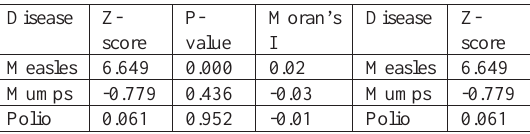
Table 2. Spatial autocorrelation analysis (Moran’s I) results for diseases; according to the table above, only measles shows a significant clustering pattern based on